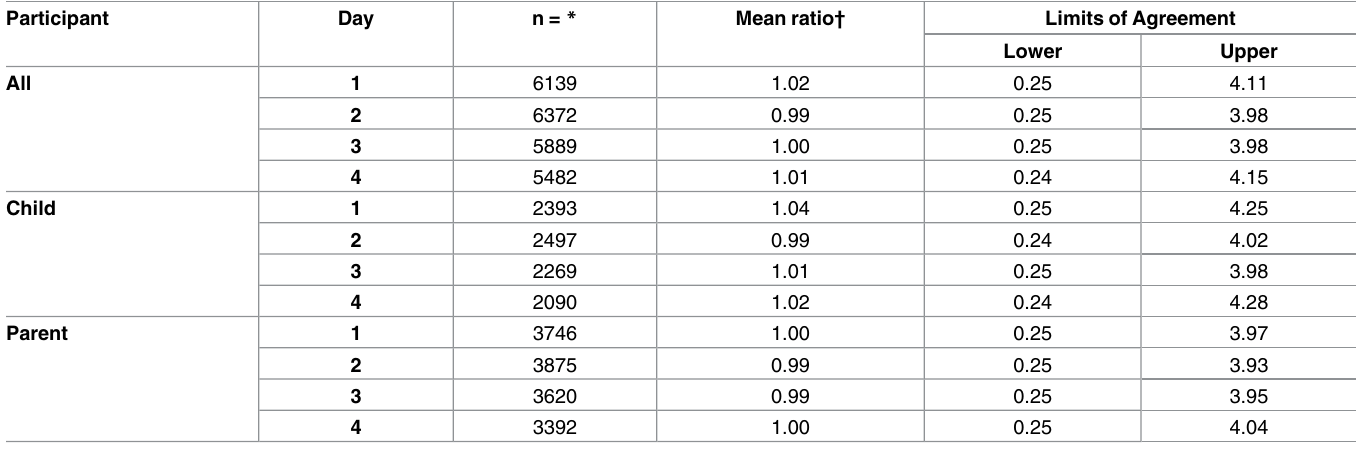
Table 3. Agreement of estimatesof portion size using YPFA with weighed food diaries for day 1 of the food diary compared with day